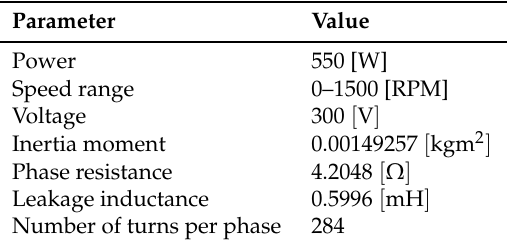
Table 3. Parameters of the studied 8/6 SRM.